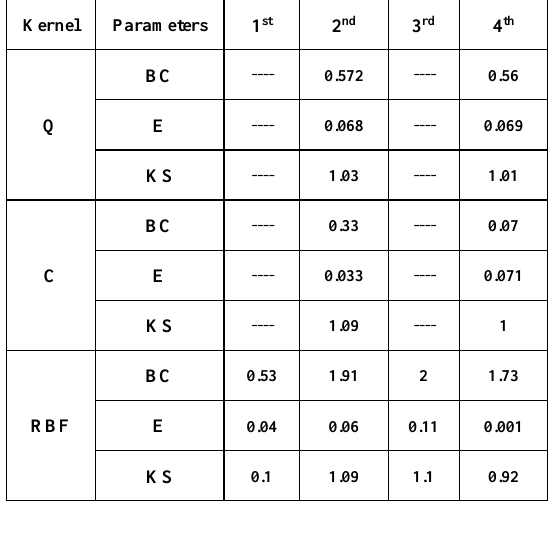
Table 1: SVR parameters for four scenarios